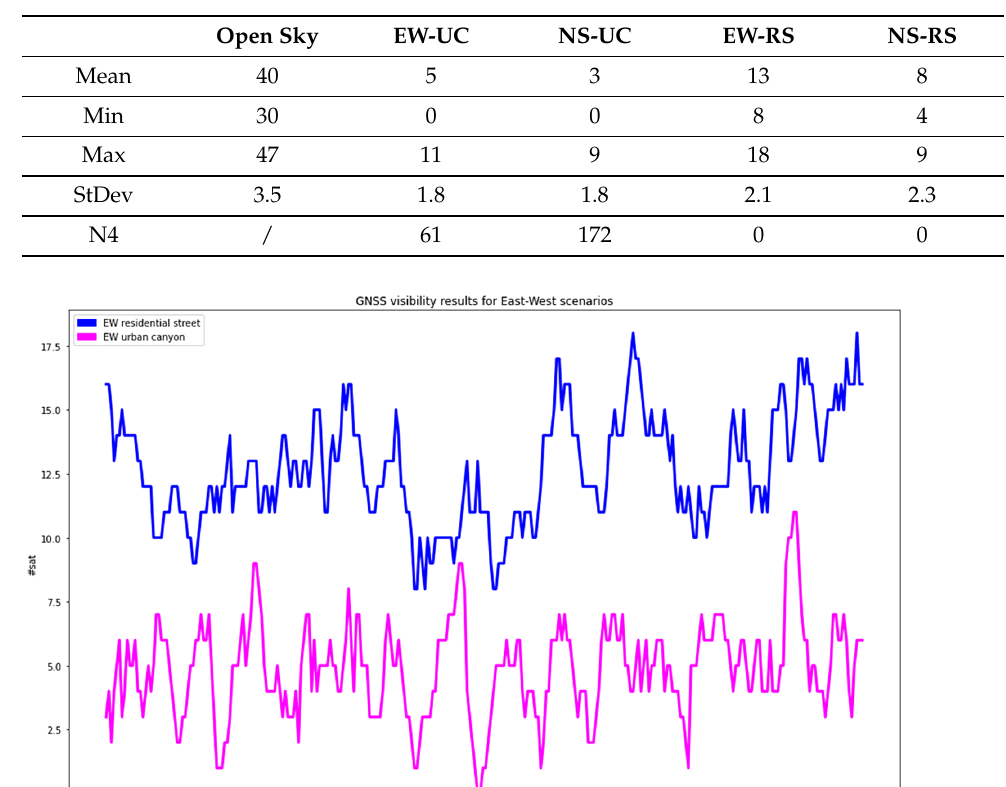
Table 4. Statistics of visible GNSS satellites in urban scenarios compared with open sky condi-